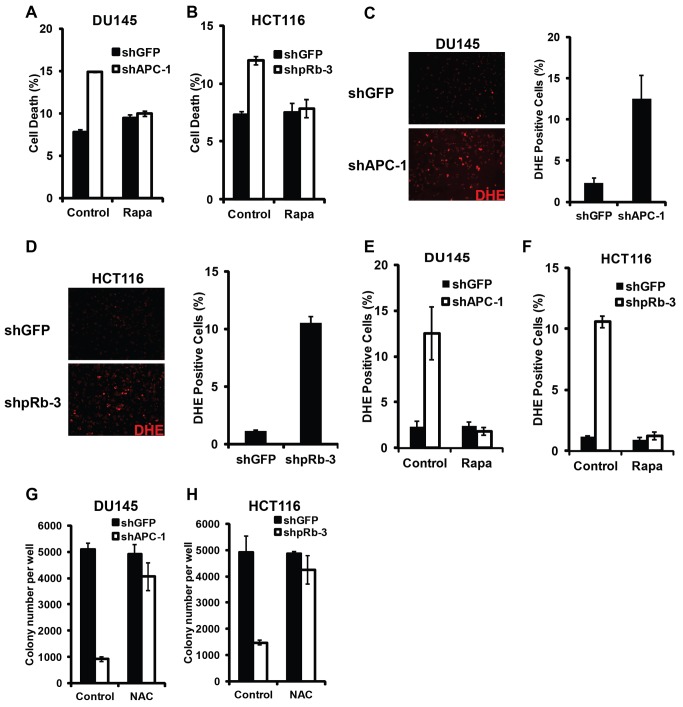
Synergistic cell death induced by hyperactivated Wnt signaling and Rb inactivation require TORC1 activity and involve ROS induction.Synergistic cell death from APC knockdown in DU145 cells (A) and Rb knockdown in HCT116 cells (B) was rescued by Rapamycin, an inhibitor of TORC1 activity. Both APC-knockdown DU145 cells (C) and Rb-knockdown HCT116 cells (D) grown in soft agar showed increased ROS level by DHE staining. (E–F) Rapamycin blocked ROS induction in APC-knockdown DU145 cells (E) and in Rb-knockdown HCT116 cells (F). (G–H) NAC, an antioxidant, rescued the ability of APC-knockdown DU145 (G) and Rb-knockdown HCT116 (H) cells to form colonies in soft agar.